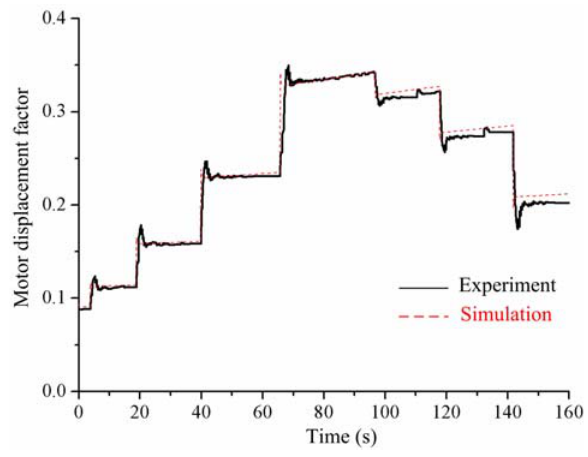
Figure 12. Motor speed responses of the HESGS under varied load power step.